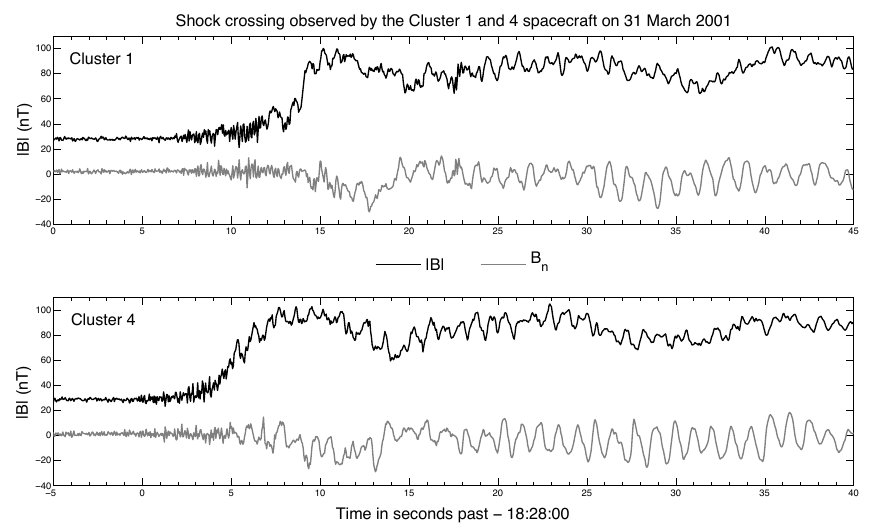
Fig. 3. The magnetic field profile of a shock crossing observed by the Cluster 1 and 4 satellites on 31 March 2001. The time interval shows the crossing several seconds upstream and around 30s downstream of the crossing. The black line shows the magnitude of the magnetic field whereas the grey line is the magnetic field projected along the normal. The upper and lower panels represent the Cluster 1 and Cluster 4 spacecraft,